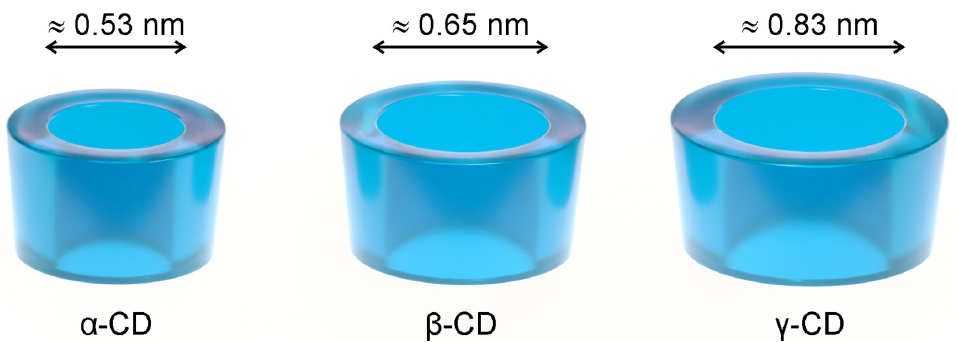
Figure 1. The three most abundant native cyclodextrins (CDs), α -CD, β -CD, and γ -CD, schematically drawn as truncated cones. An estimate of the inner cavity diameter is presented for each